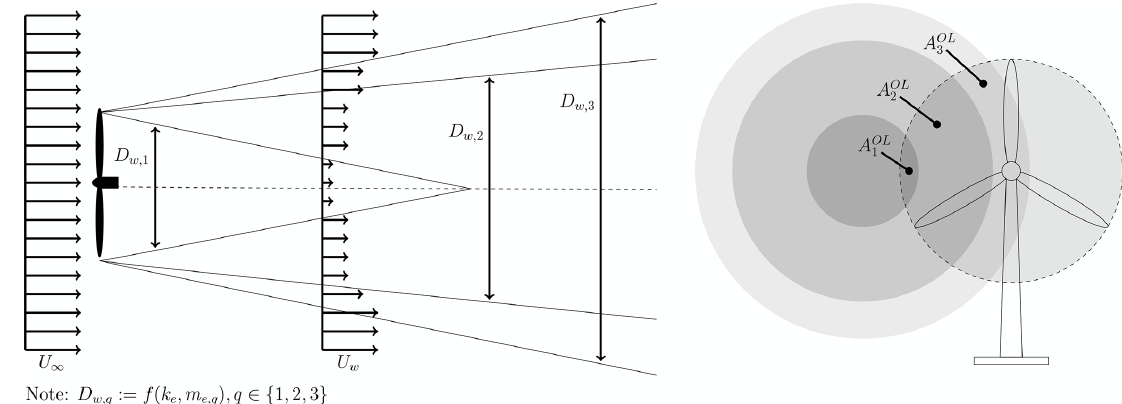
Figure 2. Schematic of the Floris wake model. The model has three zones with varying diameters, D w,q , that depend on tuning parameters k e and m e,q . The effective hub velocity is computed using the overlap ratio, A OL q , of the part of the rotor-swept area overlapping each wake zone respective to the total rotor-swept area.